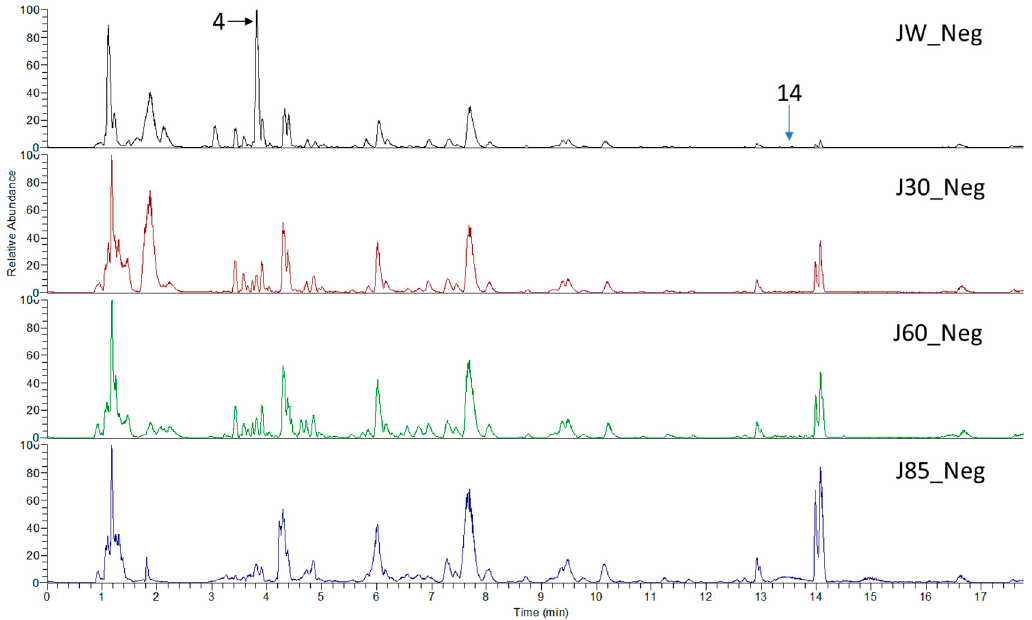
Figure 2. The chemical profile of SG extracts analyzed by UPLC-MS (negative). The numbers indicate the